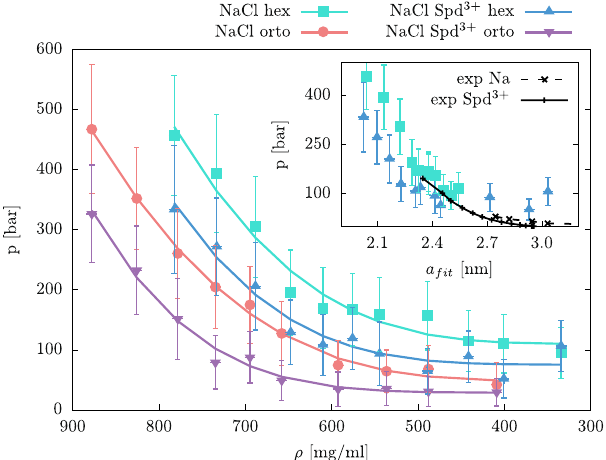
Figure 2. Osmotic pressure (mean and standard deviation) of DNA arrays as a function of the DNA density. The results are shown for hex and orto lattices and at two bathing solution setups (1 M NaCl concentration with pure Na + counterions and mixed Na + /Spd 3 + counterions). The exact results are shown with points, while the lines are used to guide the eye and show the exponential fit. Every point corresponds to a separate simulation. Inset: Osmotic pressure (mean and standard deviation) of the hexagonal array with Spd 3 + counterions as a function of fitted (to mean DNA positions) lattice parameter a . The black dotted and full lines correspond to the experimental observations in the presence of monovalent Na and multivalent Spd 3 + solution, respectively 8, 89 .